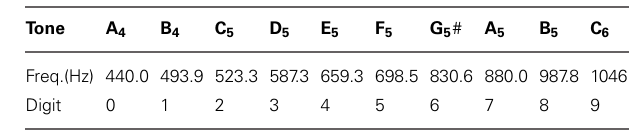
Table 1 | Paired tones and digits in multi-sensory fusion